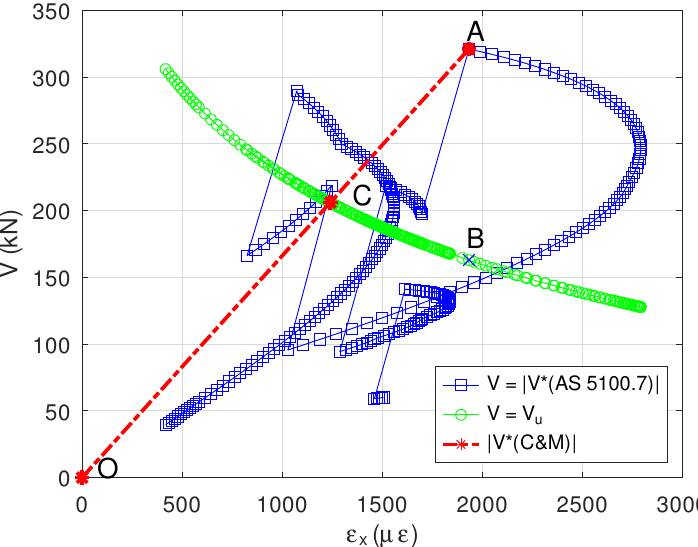
Figure 15. Effect of the proportionally increased shear on the two-span bridge